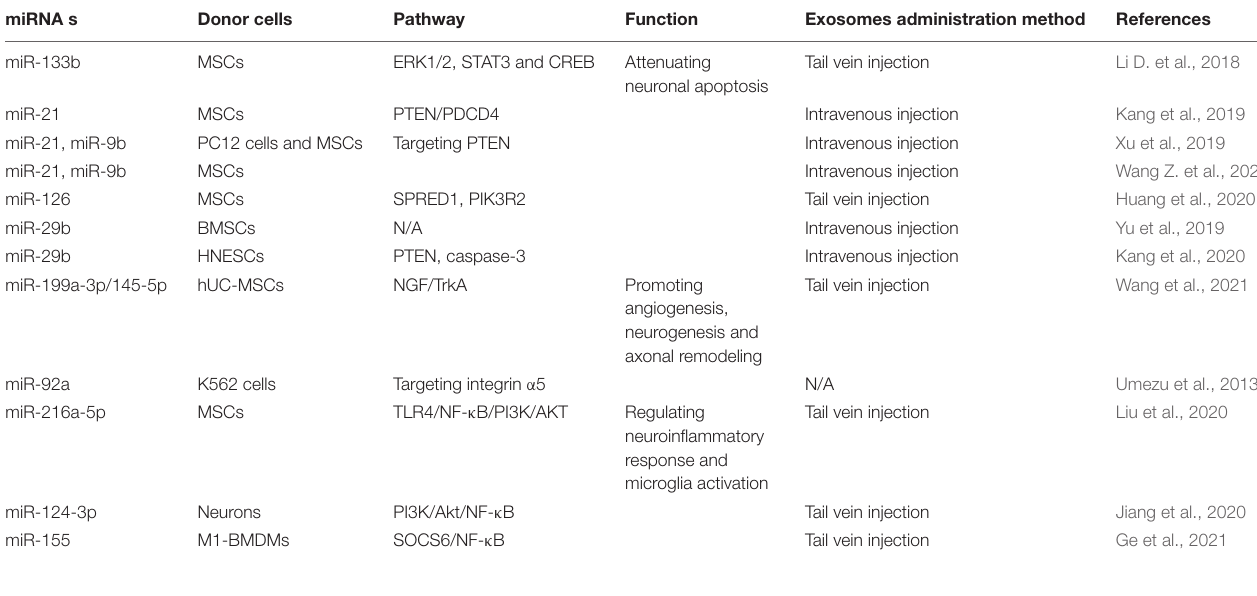
TABLE 1 | The roles of exosomal miRNAs in SCI. miRNA